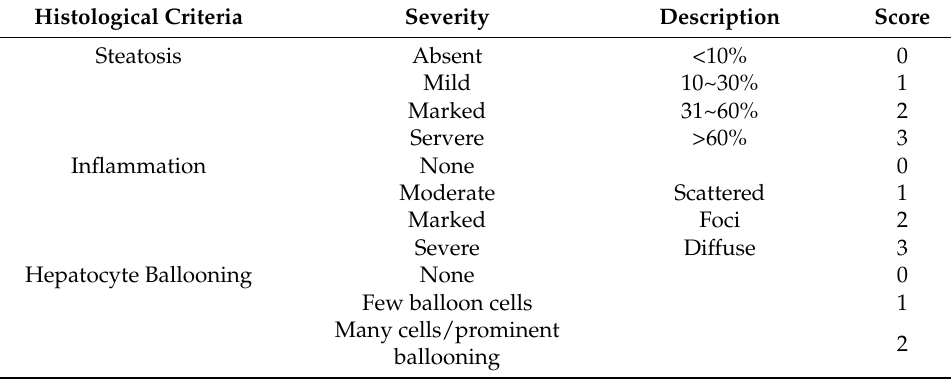
Table 1. Overview of the NAFLD Activity Score